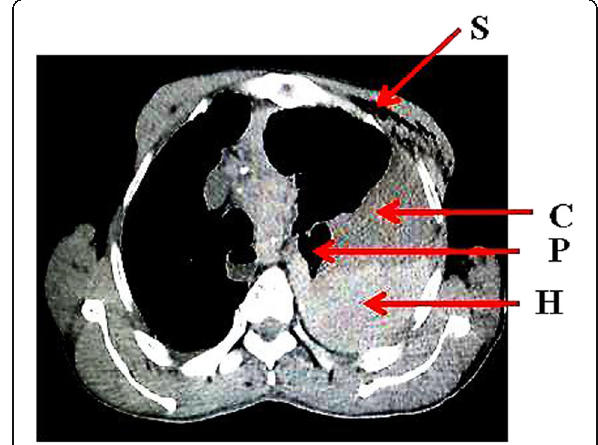
Fig. 8 Multiple gunshot injuries. PMCT axial image in the chest region showing lacerations of the collapsed left lung (C), hemothorax (H), pneumothorax (P), and left-sided subcutaneous surgical Fig. 9 Multiple gunshot injuries. PMCT axial image showings liver lacerations (arrow) and hemoperitoneum ( Δ